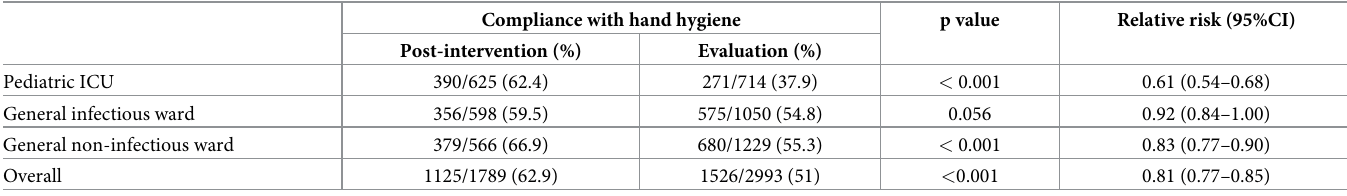
Table 5. The hand hygiene compliance among healthcare workers over the study